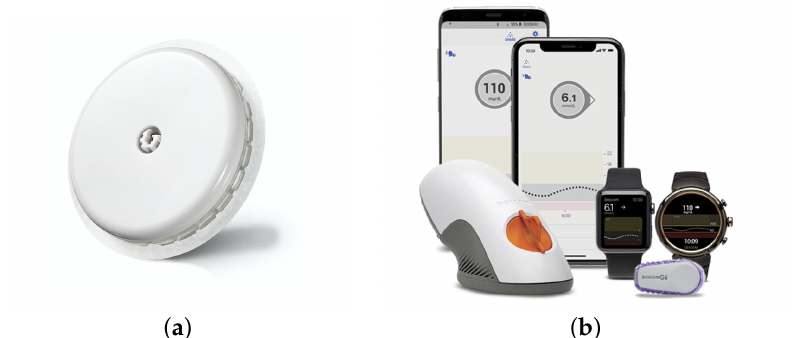
Figure 15. Commercial systems of FreeStyle Libre 2 and Dexcom G6. ( a ) FreeStyle Libre 2 sensor (Reprinted with permission from Ref. [135] © Abbott GmbH). ( b ) Dexcom G6 sensor (Reprinted with permission from Ref. [136] © Dexcom,